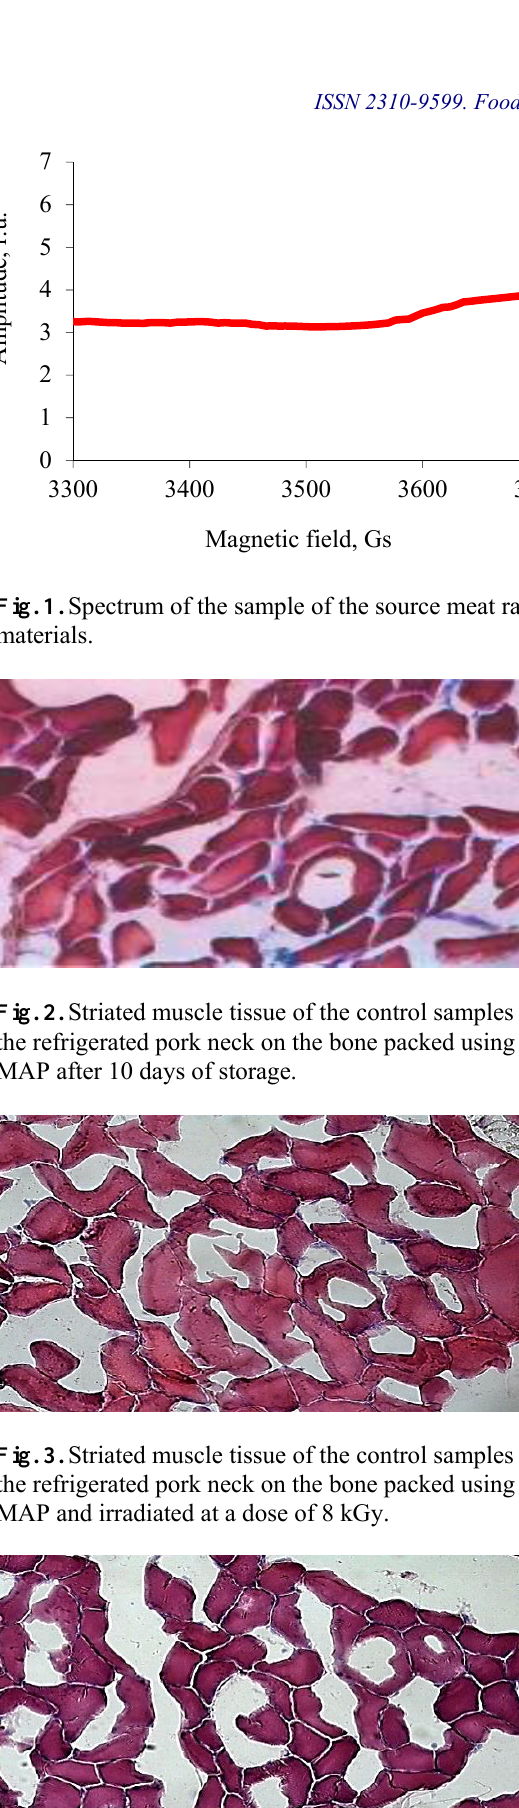
Fig. 5. Striated muscle tissue of the control samples of the refrigerated pork neck on the bone packed using MAP after 20 days of